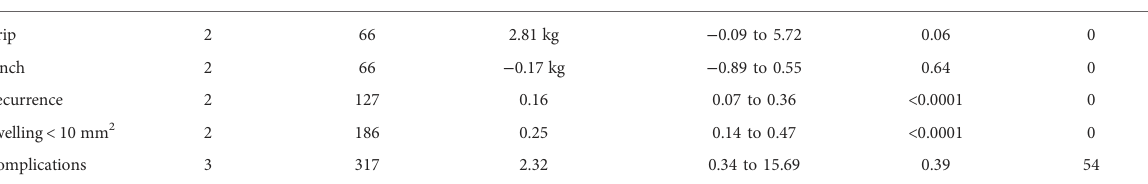
TABLE 2 Other clinical outcomes of the meta-analysis. Strati fi cation